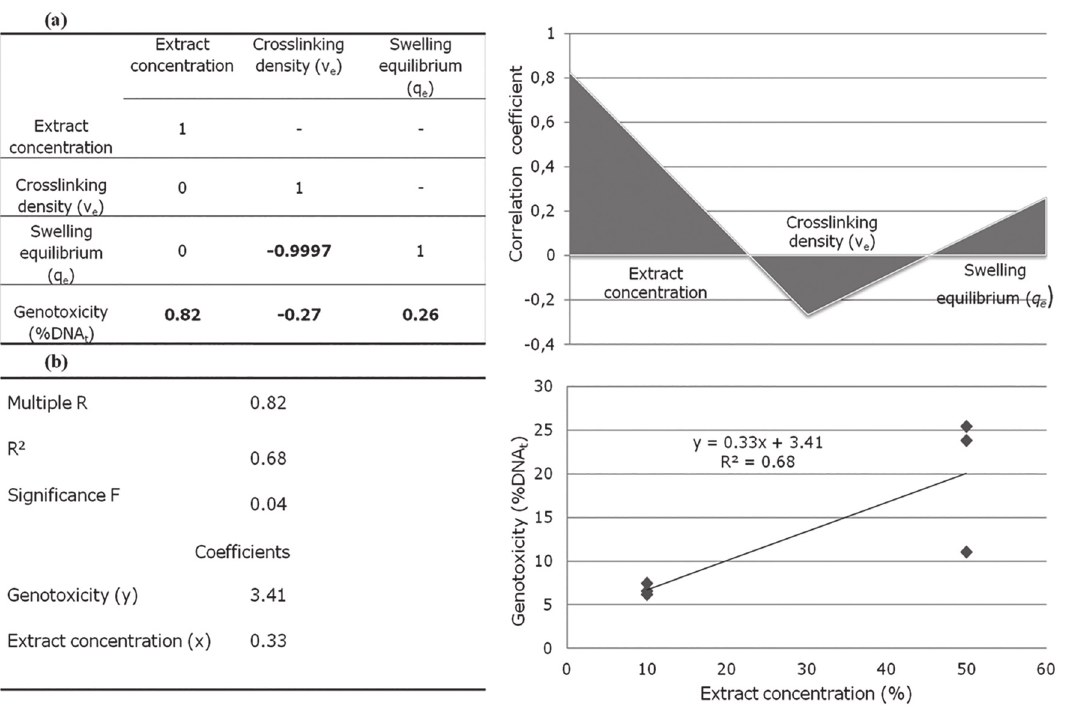
Figure 4: (a) Multiple correlation analysis employed to determine the strength and direction of the association between the independent variables (extract concentration, crosslinking density ( ν ) and swelling equilibrium ( q )) and the one dependent variable (%DNAt). e e Correlation coefficient ranges between – 1 to +1, and quantifies the stenght (the closer coefficient is to 1, the stronger linear association is) and the direction (positive or negative) of the association. (b) Regression analysis of the relationship between extract concentration and genotoxicity, based on significant correlation among these two